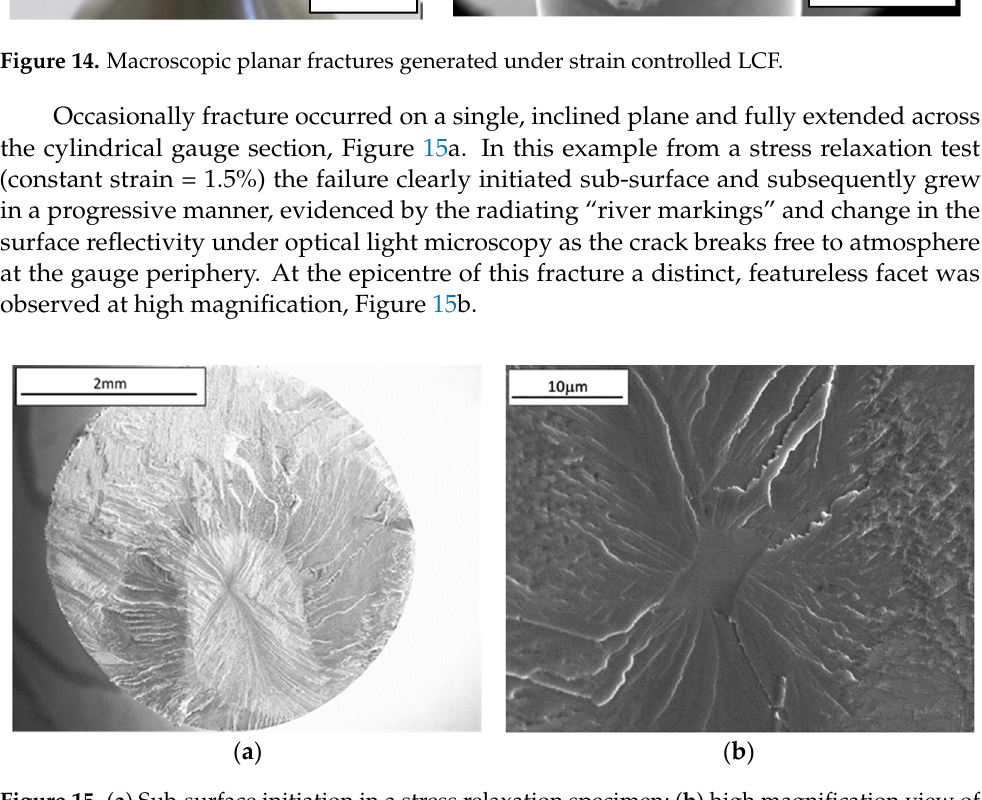
Figure 14. Macroscopic planar fractures generated under strain controlled LCF.